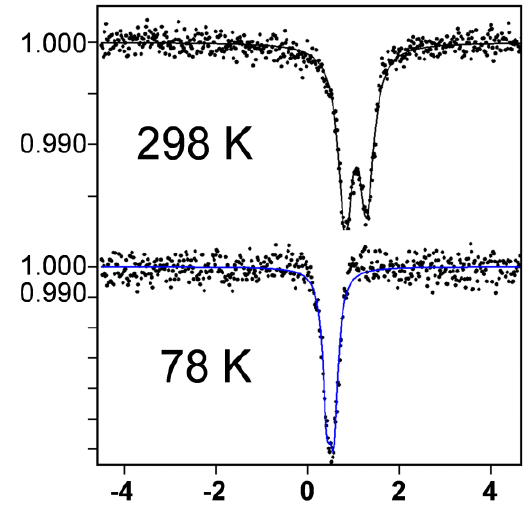
Figure 2. 57 Fe Mössbauer spectra of the spiral